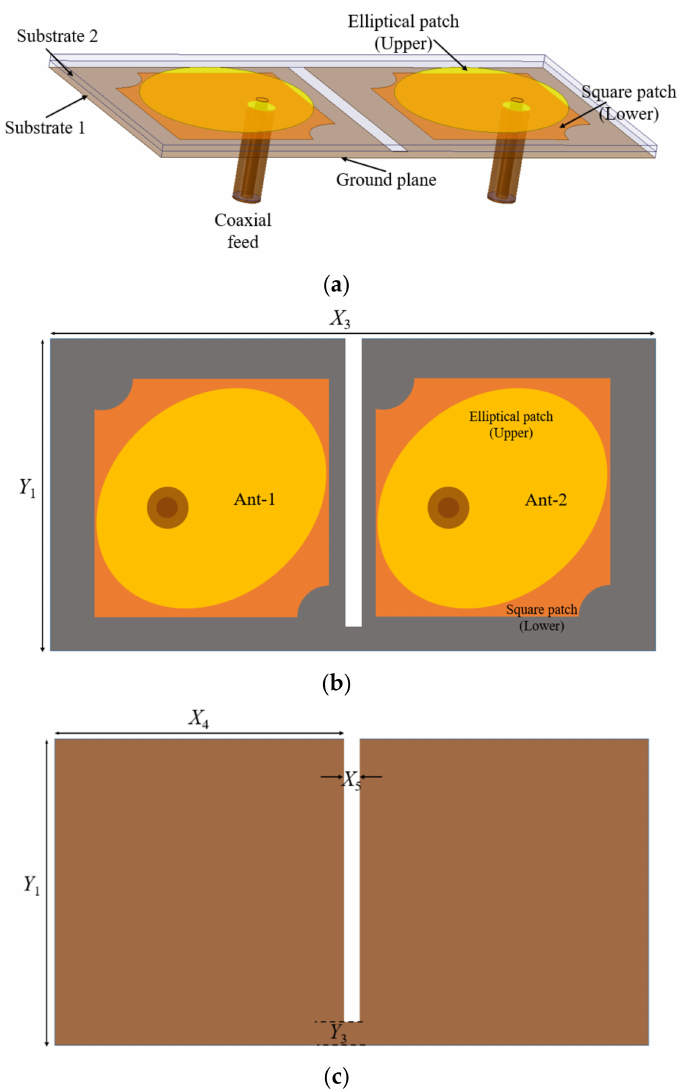
Figure 5. Geometry of the two-element stacked MIMO antenna: ( a ) side view; ( b ) top view; ( c ) ground